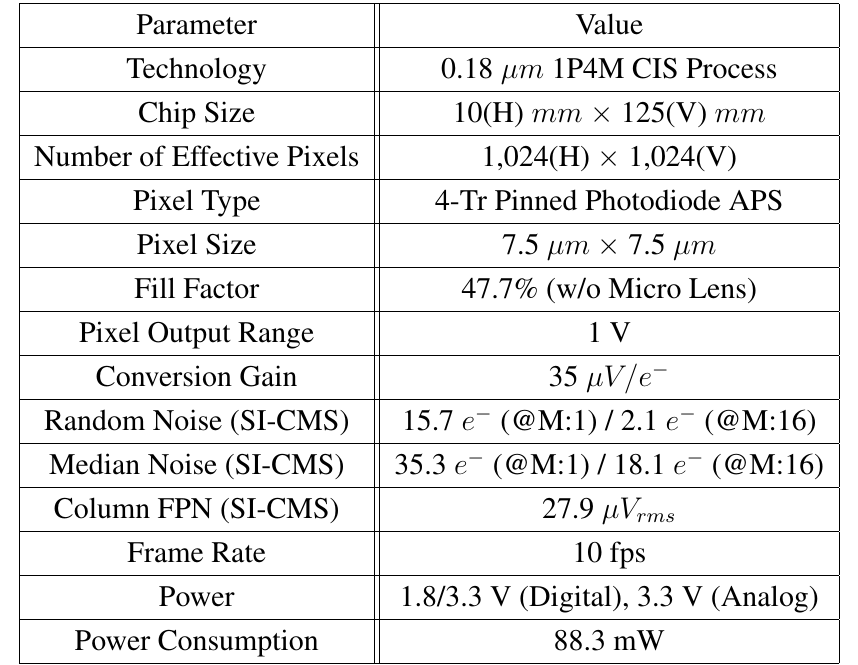
Table 1. Summary of 1Mpixel Pinned Photodiode CMOS Image